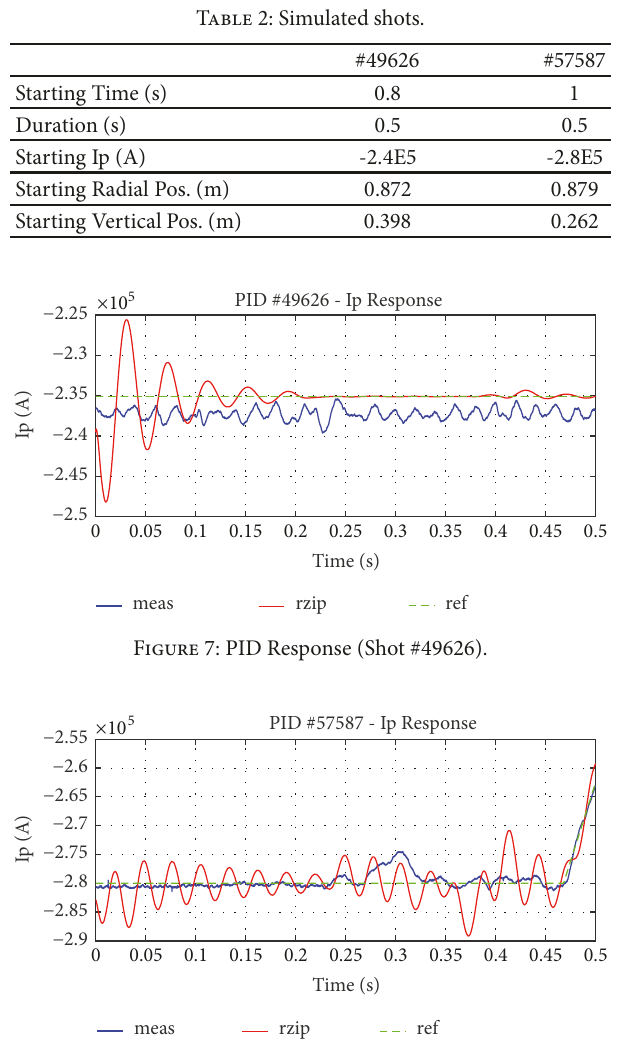
Figure 8: PID response (Shot #57587).